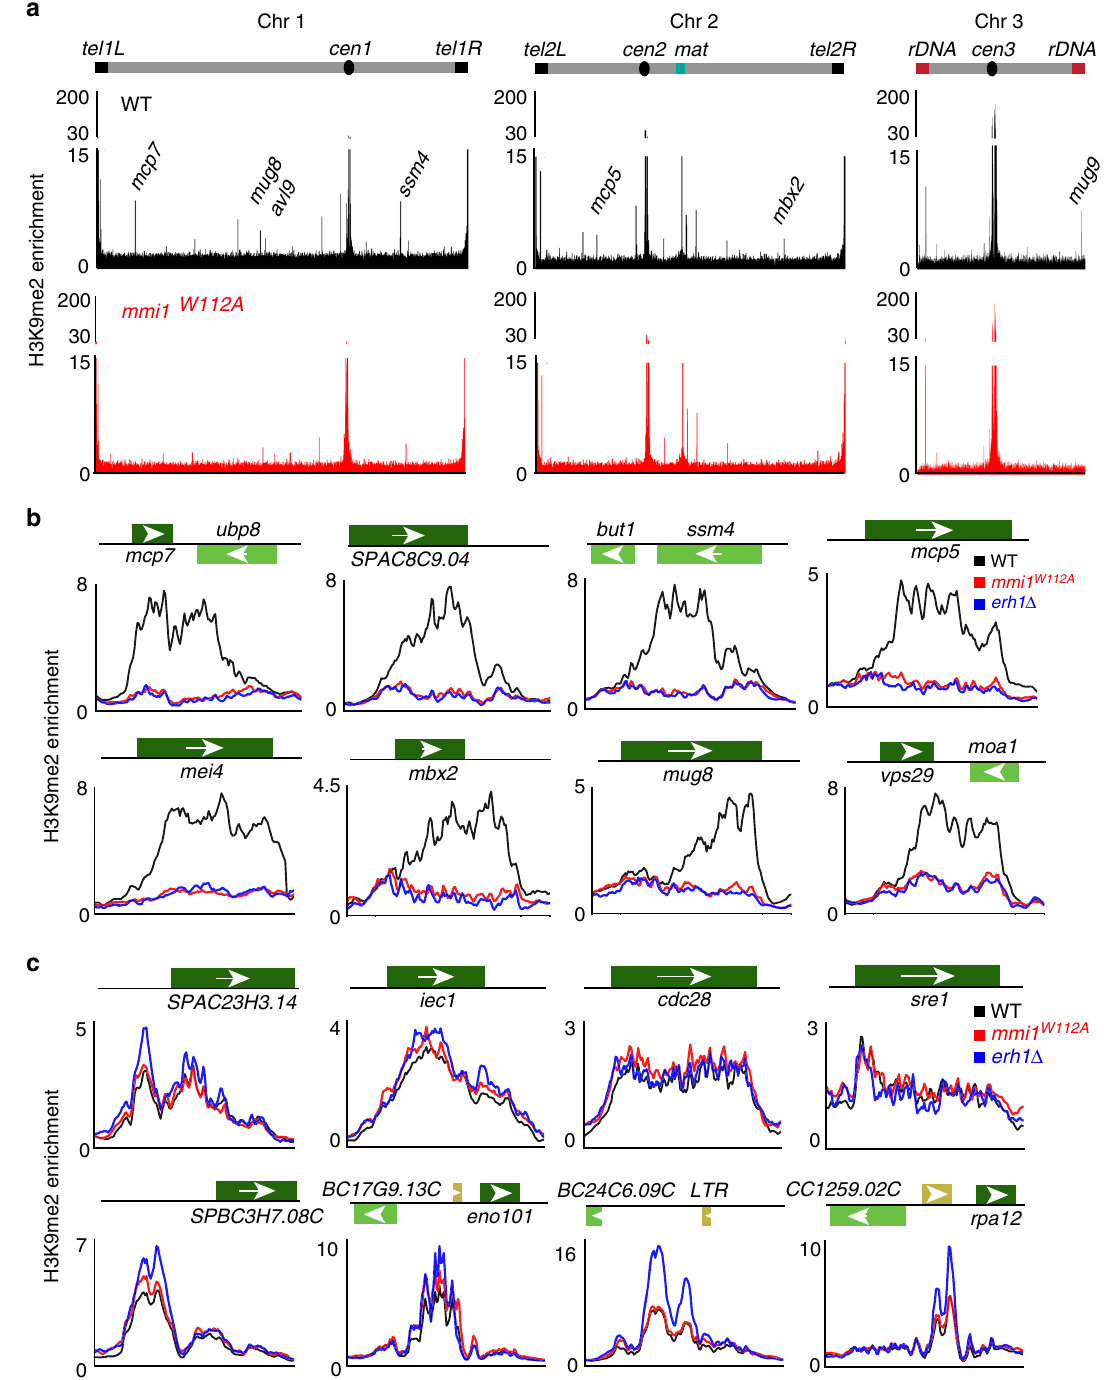
Fig. 5 Mmi1 W112A affects EMC-dependent facultative heterochromatin islands. a Genome-wide ChIP-seq pro fi les showing enrichment of histone H3 dimethylation (H3K9me2) in WT and mmi1 W112A cells. Examples of several individual heterochromatin islands are indicated. b H3K9me2 enrichment ChIP- seq pro fi les of EMC-dependent islands. c H3K9me2 enrichment ChIP-seq pro fi les of EMC-independent islands. The color scheme used in all plots shown is WT (black), mmi1 W112A (red), and erh1 Δ